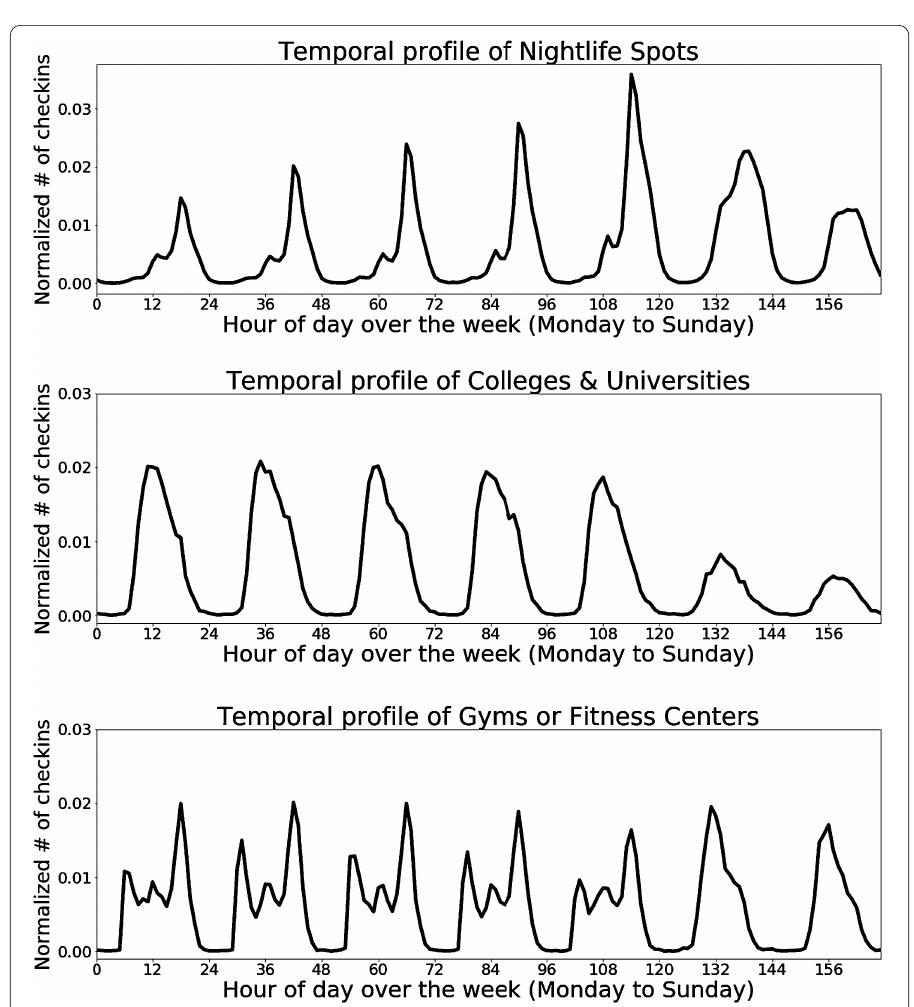
Figure 2 Temporal profiles. Normalized temporal profile of different categories of